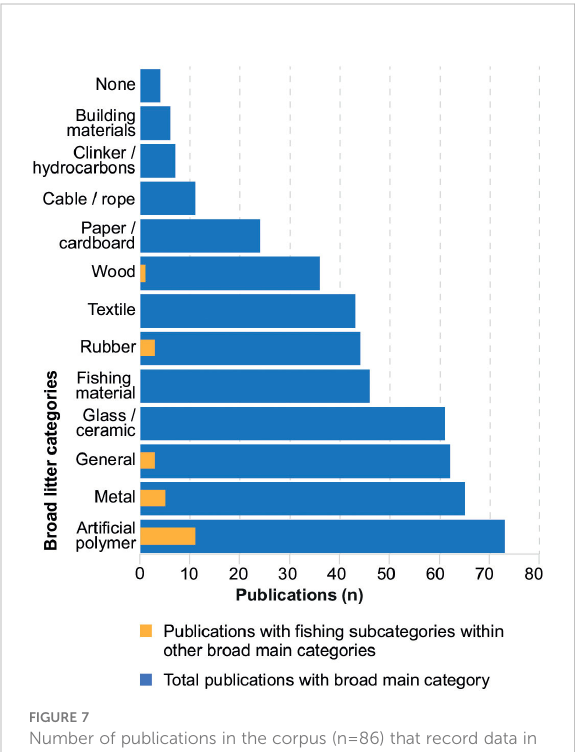
FIGURE 7 Number of publications in the corpus (n=86) that record data in each of the broad litter classi fi cation groupings (blue). Number of publications that included fi shing materials as subcategories in other broad litter classi fi cation groups (yellow).